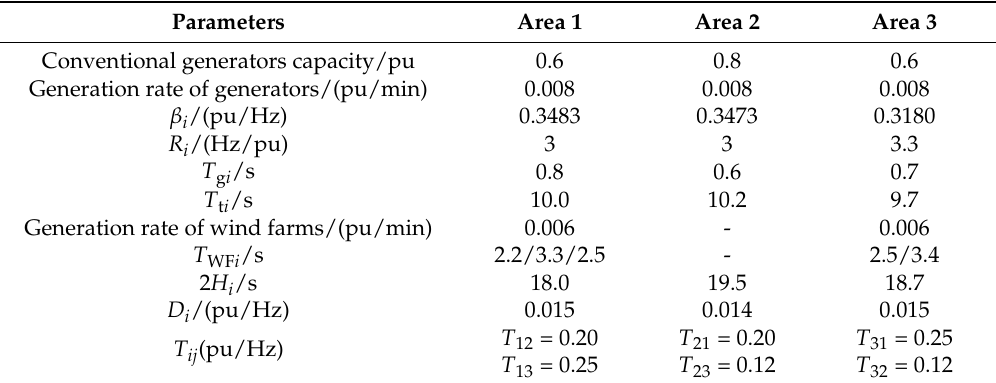
Table 2. Parameters of experimental examples.